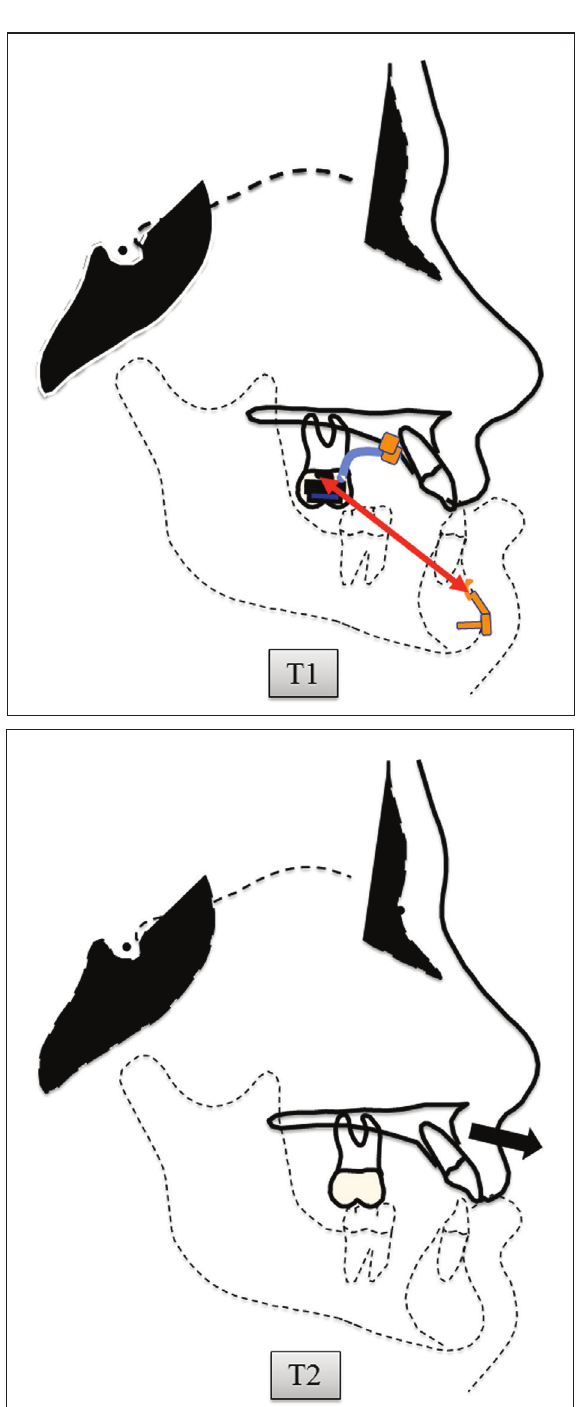
Figure 4. Cephalometric tracings depicting significant changes seen with Hybrid Hyrax-Mentoplate protocol before (T1) and after (T2)